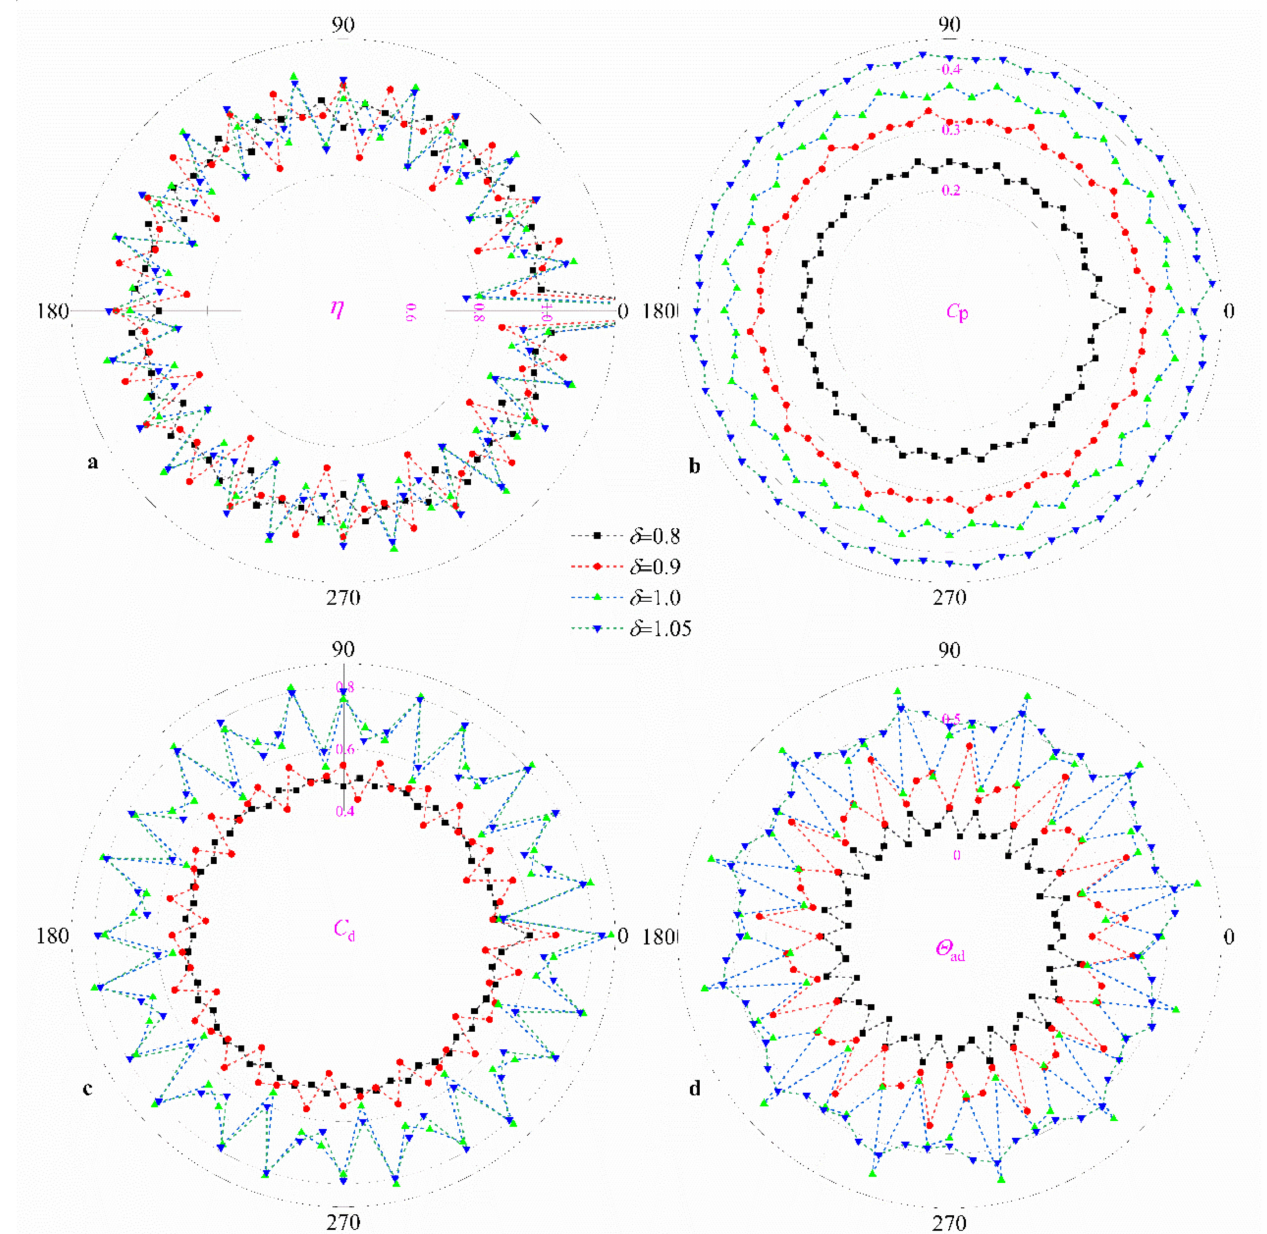
Figure 20. Distribution of ( a ) mass-flow-rate ratio η , ( b ) total-pressure-loss coefficient C p , ( c ) discharge coefficient of holes C d , and ( d ) adiabatic effectiveness Θ ad for different radius ratios of nozzles to holes δ